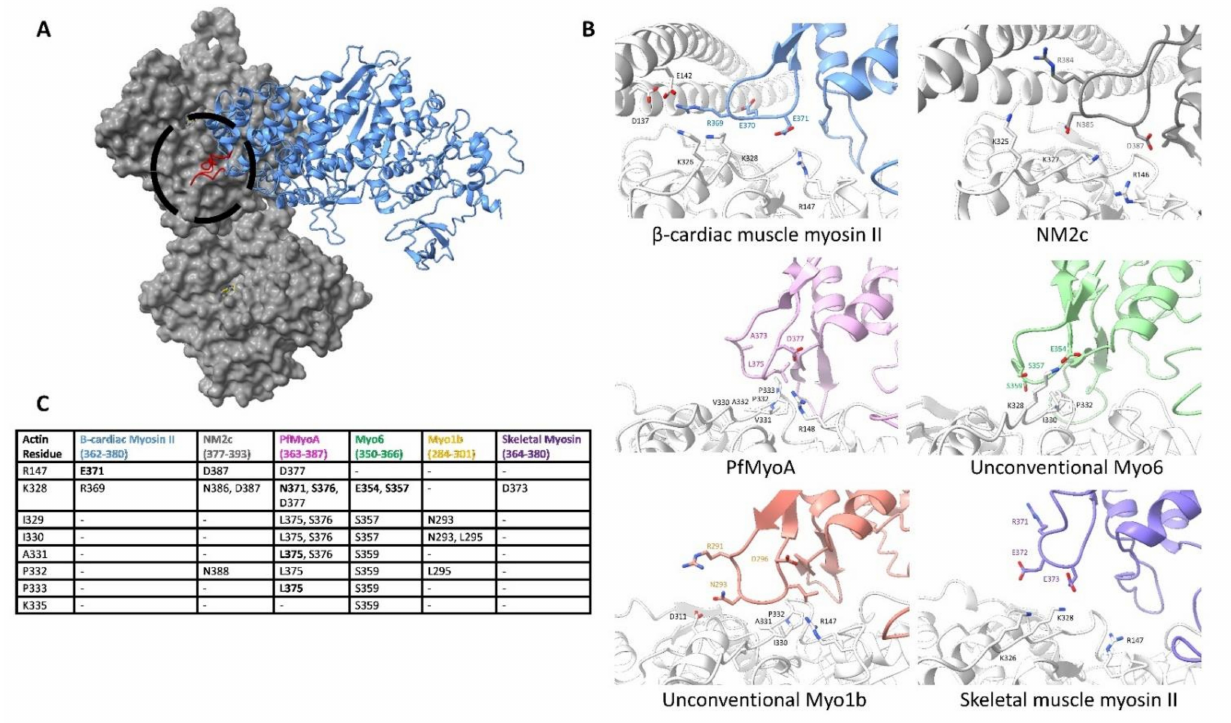
Figure 7. Actin subdomain 3 binds to myosin loop 4 to form the edge of the actin-myosin interface. ( A ). The overall positioning of the actin surface relative to myosin loop 4. The motor domain is in blue while loop 4 is colored in red and circled; actin is in gray. ( B ). The residue-level binding interface between actin subdomain 3, tropomyosin, and myosin loop 4 from the myosin structures is indicated in Supplementary Item Table S2. Actin backbone and residues are colored white, while myosin residues are colored by isoform. Noted residues involved in binding are shown and labeled. The presence of tropomyosin impacts the interactions between actin and myosin. In isoforms that interact with tropomyosin, like cardiac β -myosin II, the residues at the tip of the loop interact with the coiled-coil of tropomyosin. Without tropomyosin, the tip of the loop can reach across to actin subdomain 3, as seen in the unconventional myosin 1b. ( C ). Residue-to-residue contacts determined for the cryo-EM structures indicated in Supplementary Item Table S2. All residues on myosin that come within 5 Å of the indicated actin residue are listed with residues coming within 4 Å appearing in bold. The actin sequence is based on the Chicken ACTA1 numbering (UniProt: